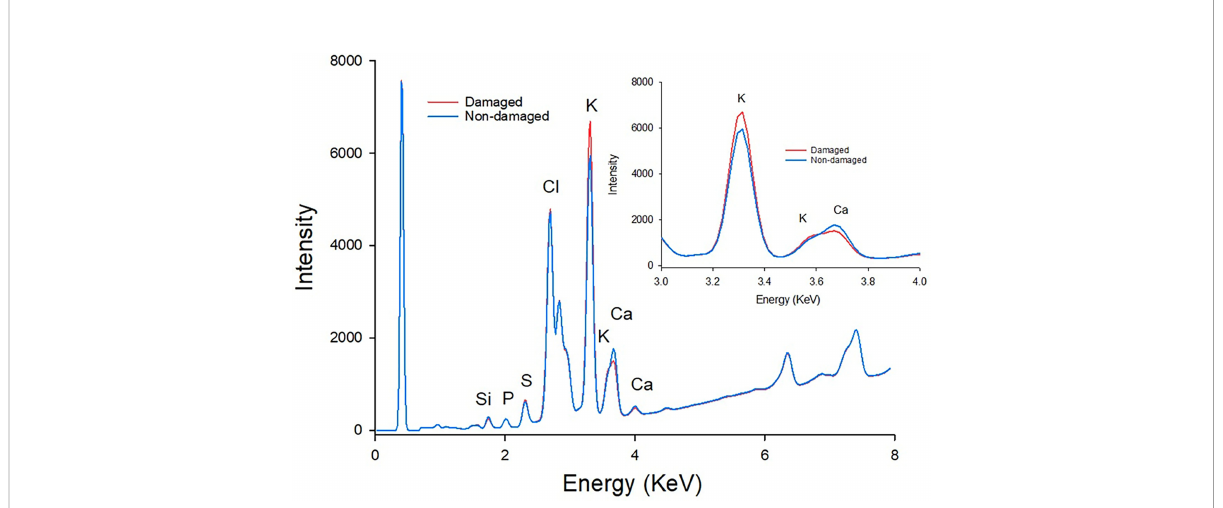
FIGURE 2 General XRF spectra for ‘ Granny Smith ’ apple epidermis for fruit with (red) and without (blue) bitter pit; K and Ca peaks details in small graphic. Similar spectra were found in the other